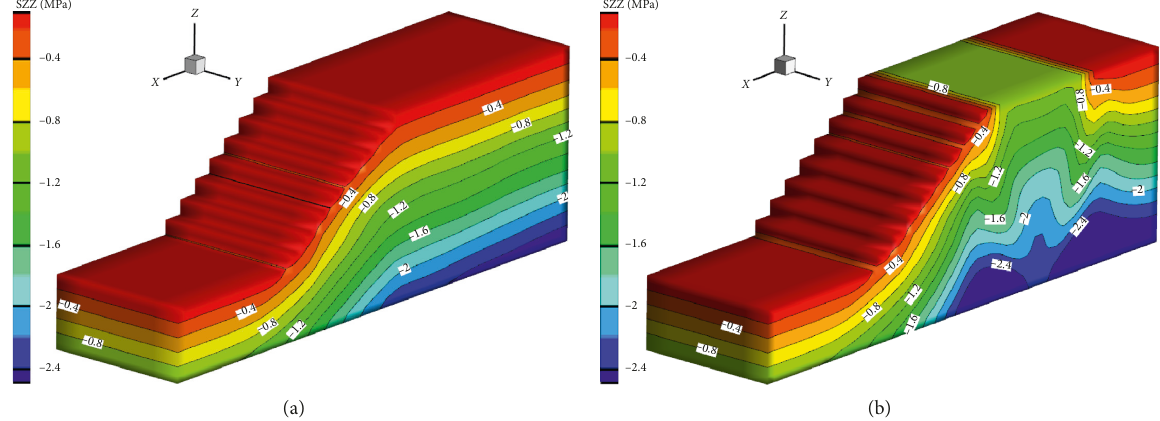
Figure 3: Vertical stress of slope. (a) No dumping. (b) Dumping.